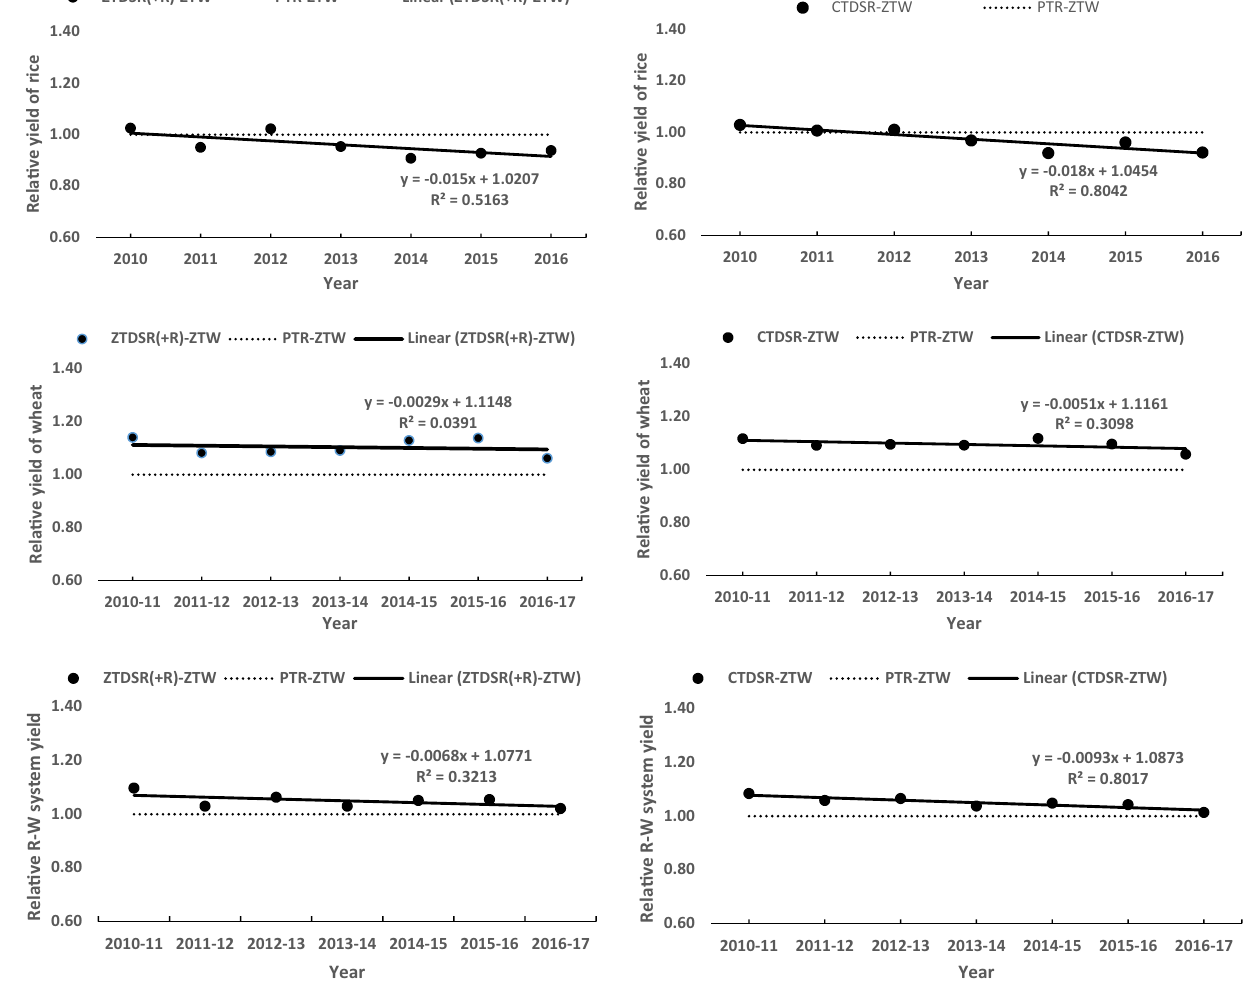
Fig. 3 Relative yield of rice (top), wheat (middle) and rice–wheat system (lower) under ZTDSR (+ Residue)-ZTW (left) and CTDSR-ZTW (right) as compared to